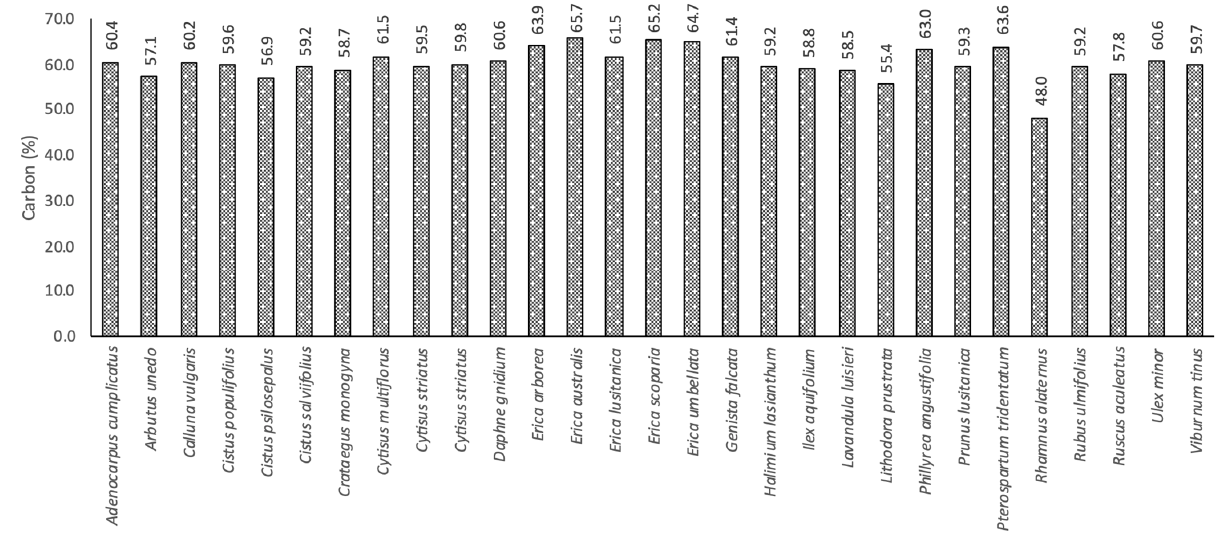
Figure 7. Hydrogen content (%) of the studied species.